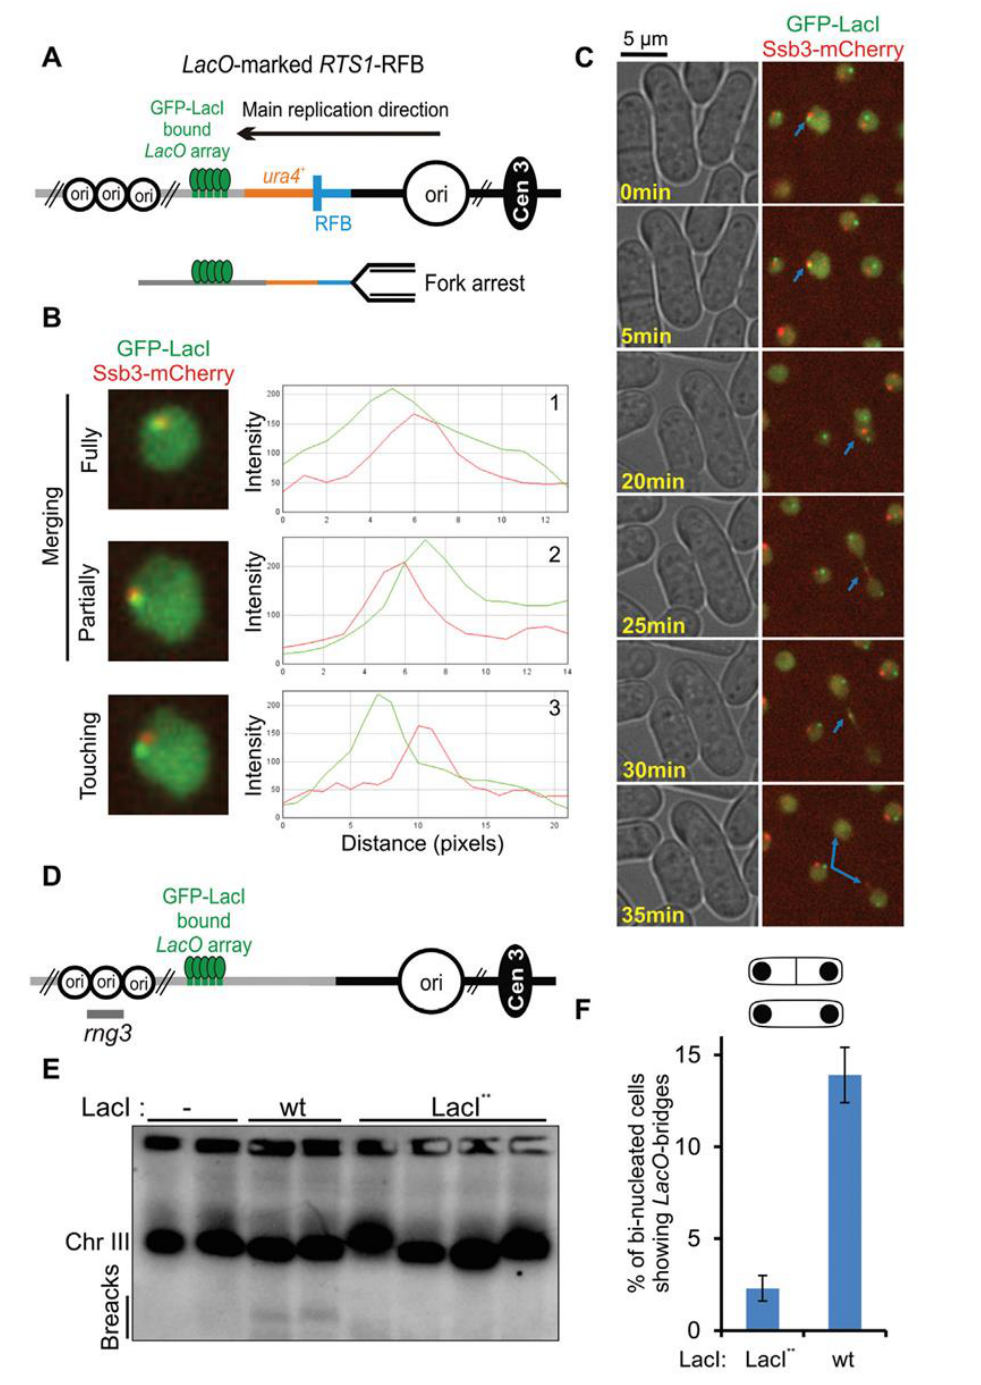
FIGURE 19: A fluorescently-marked RFB to follow in vivo the fate and processing of a single blocked fork in fission yeast. (A) Diagram of the LacO- marked RTS1 -RFB locus located on the chromosome III of S. pombe . The blue bar indicates the RTS1 -RFB and its polarity. Main replication origins (ori, black circles) located upstream and downstream from the RTS1 -RFB are indicated. GFP-LacI (green ellipses) bound to LacO arrays (green bars) are integrated  7 kb away from the RTS1 -RFB, on the telomere-proximal side of ura4 gene (red bar). When Rtf1 is expressed, >90% of forks emanating from the strong centromere-proximal replication origin, and moving towards the telomere, are blocked. (B) Example of Ssb3- mCherry foci being recruited to the active RFB. Three situations were considered: GFP-LacI and Ssb3-mCherry foci were fully (1) or partially merg- ing (2), or they were touching each other (3). (C) Example of an unprotected fork (identified via the presence of Ssb3-mCherry-positive signal on LacO -marked RTS1 -RFB in ON condition, blue arrow) in G2 (time point 0 to 20 minutes) converted into a sister chromatid bridge during mitotic progression (from 20 to 30 minutes) and finally resolved (at 35 minutes). (D) Diagram of the GFP-LacI bound to LacO arrays located on the chro- mosome III of S. pombe without RTS1 -RFB. The rng3 probe is indicated. (E) Detection of chromosome breakage by Pulse Field Gel electrophoresis followed by Southern-blotting using the rng3 probe, in the following conditions: No LacI repressor expressed (-), expression of the wild-type (wt) LacI from a multi-copy expression vector [307], expression of the LacI ** from a single copy gene and SV40 promoter [333]. (F) Quantification of LacO -bridges in indicated OPEN ACCESS | www.microbialcell.com